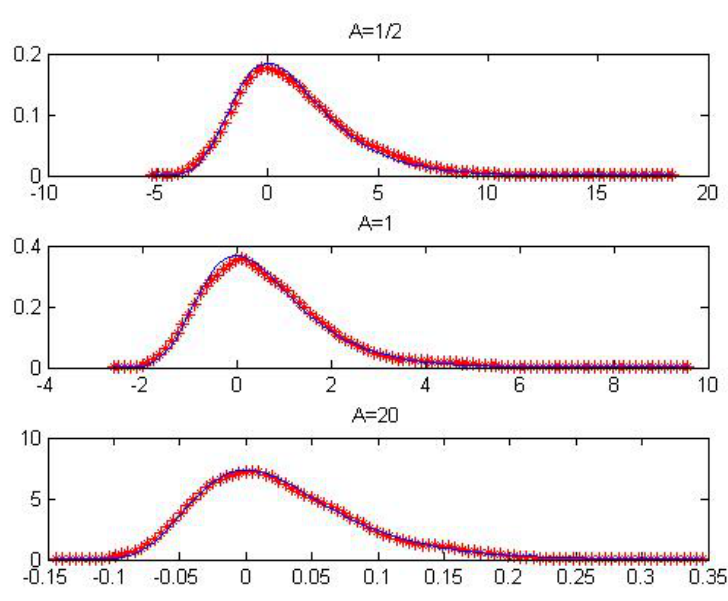
Figure 2. The sketches above show the figures of G (cid:48) exponential sequence when A = 1